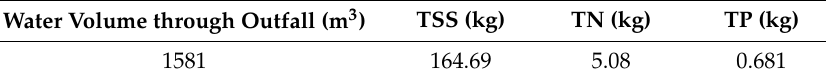
Table 4. Current pollutant wash off (rain event for water quality scenario).